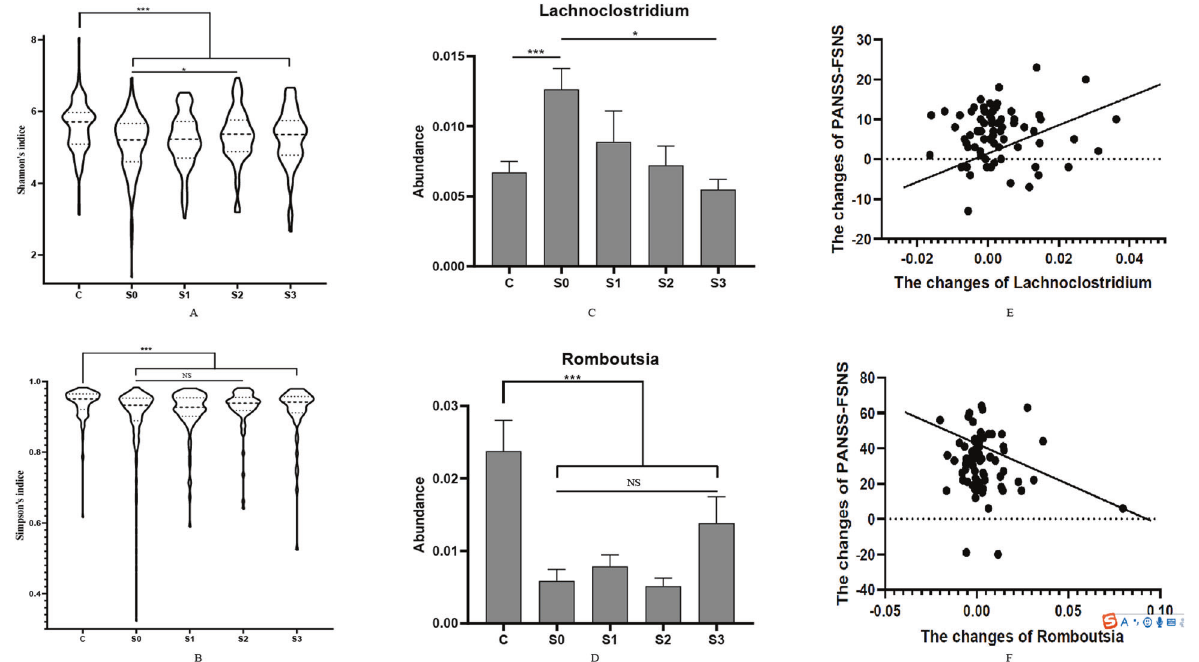
Fig. 4 Dynamic changes of gut microbiota in SCH patients. A and B α diversity, is lower in SCH patients than in HCs (indicated by C) at baseline and was increased after risperidone treatment in SCH patients. C and D SCH patients show a higher level of Lachnoclostridium and a lower level of Romboutsia than HCs. E and F The correlation between the changes of Lachnoclostridium , Romboutsia and clinical improvement measured by PANSS-FSNS. FDR were used to correct the multiple testing. * p < 0.05, ** p < 0.01, *** p < 0.